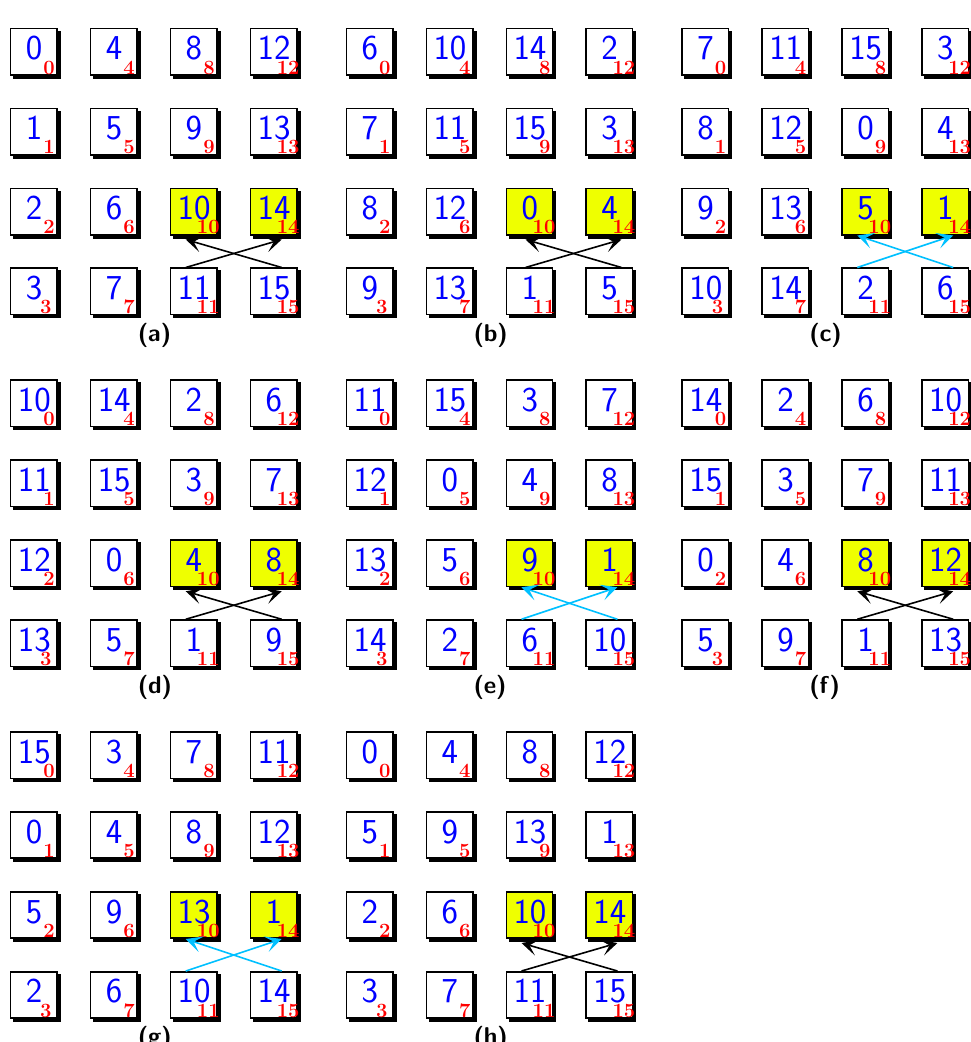
Figure 2: The contents of pipeline (a) initially, (b) after r 6 , (c) after θ ◦ r 6 , (d) after r 3 ◦ θ ◦ r 6 , (e) after θ ◦ r 3 ◦ θ ◦ r 6 , (f) after r 3 ◦ θ ◦ r 3 ◦ θ ◦ r 6 , (g) after θ ◦ r 3 ◦ θ ◦ r 3 ◦ θ ◦ r 6 , (g) finally after r ◦ θ ◦ r 3 ◦ θ ◦ r 3 ◦ θ ◦ r 6 . Note the numbers in blue denote the byte index, i.e corresponds to b i , and the subscripts in red denote the fixed register positions. As explained in Figure 1, the yellow boxes denote the byte registers implemented with scan flip-flops. Cyan and black arrows denote whether the operation θ or r is executed